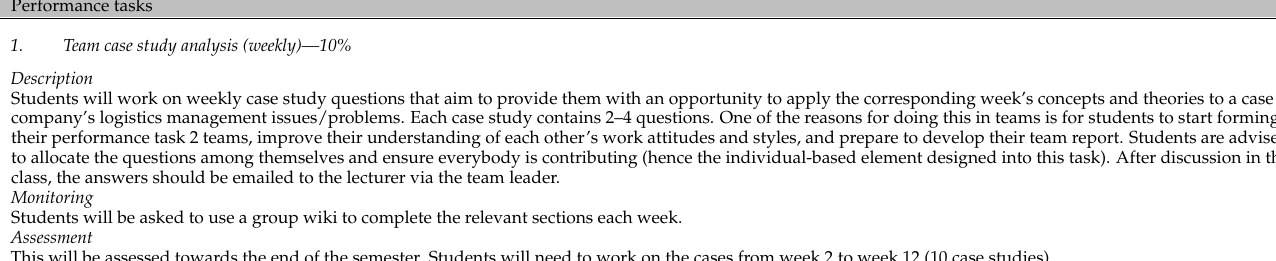
Table 2. Teaching Plan Stage 2—Determine acceptable